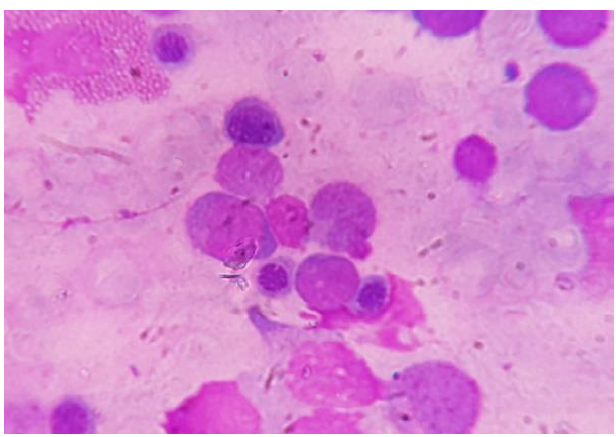
Fig. 2. Axial MR image showing extension of the lesion in Left eye.